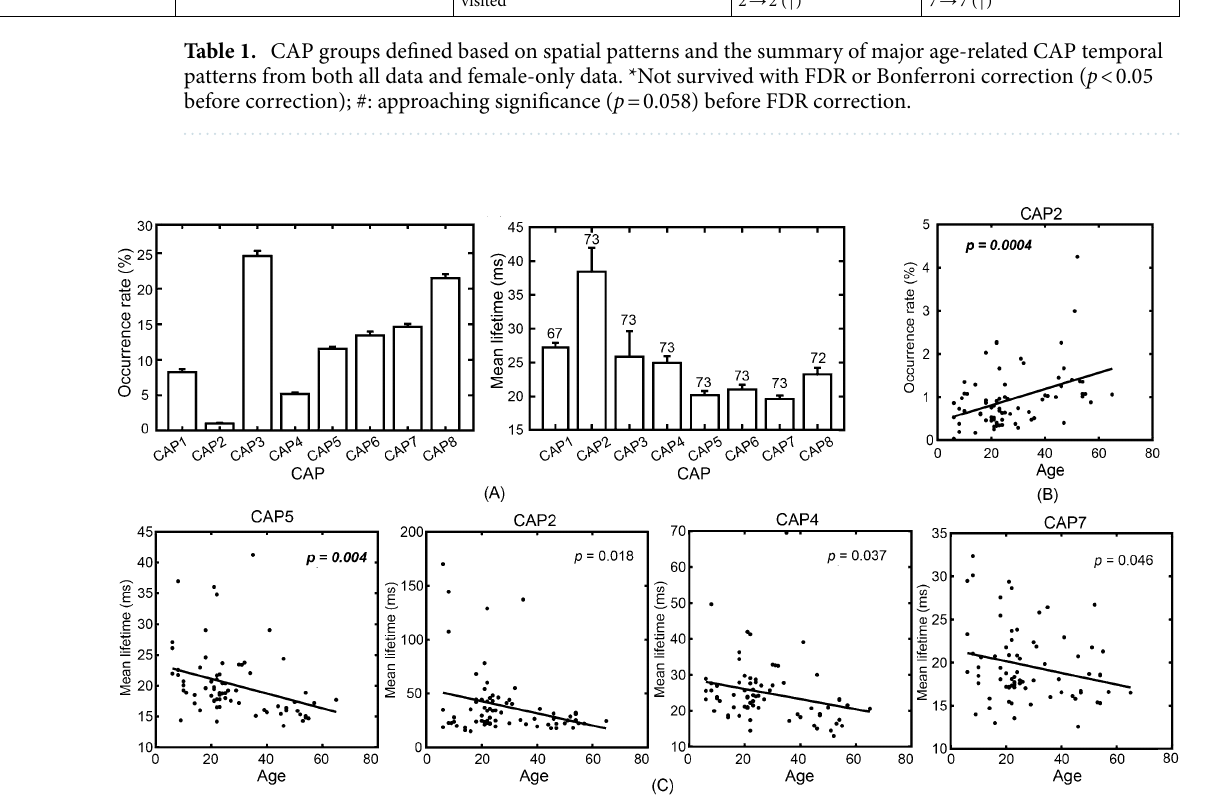
Figure 3. CAP-based temporal measures and their age-related patterns. ( A ) CAP occurrence rates and mean lifetimes. Numbers on each bar in mean lifetime indicate the number of participants (the total is 73) detected for a corresponding CAP. ( B ) Age-related occurrence rate changes of CAP2. ( C ) Age-related mean lifetime changes of CAPs 2, 4, 5, and 7. The lines in ( B ) and ( C ) are the linear regression models, whose p values are listed in the panels (bold italic fonts: survived with Bonferroni